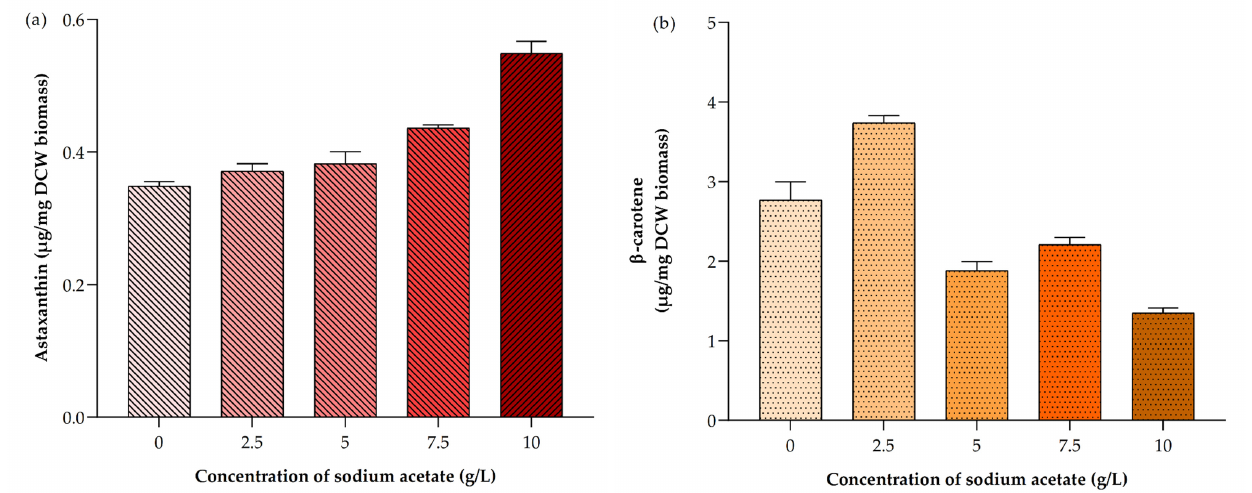
Figure 8. Impact of different concentrations of sodium acetate on Picochlorum sp. BDUG 100241 mixotrophic conditions for the accumulation of ( a ) astaxanthin and ( b ) β -carotene.